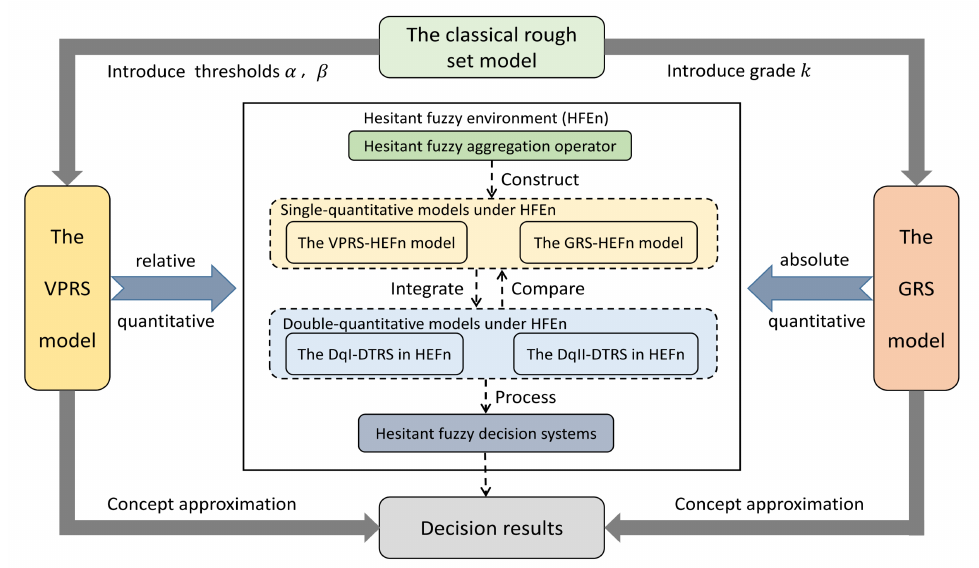
Figure 1. System diagram of our